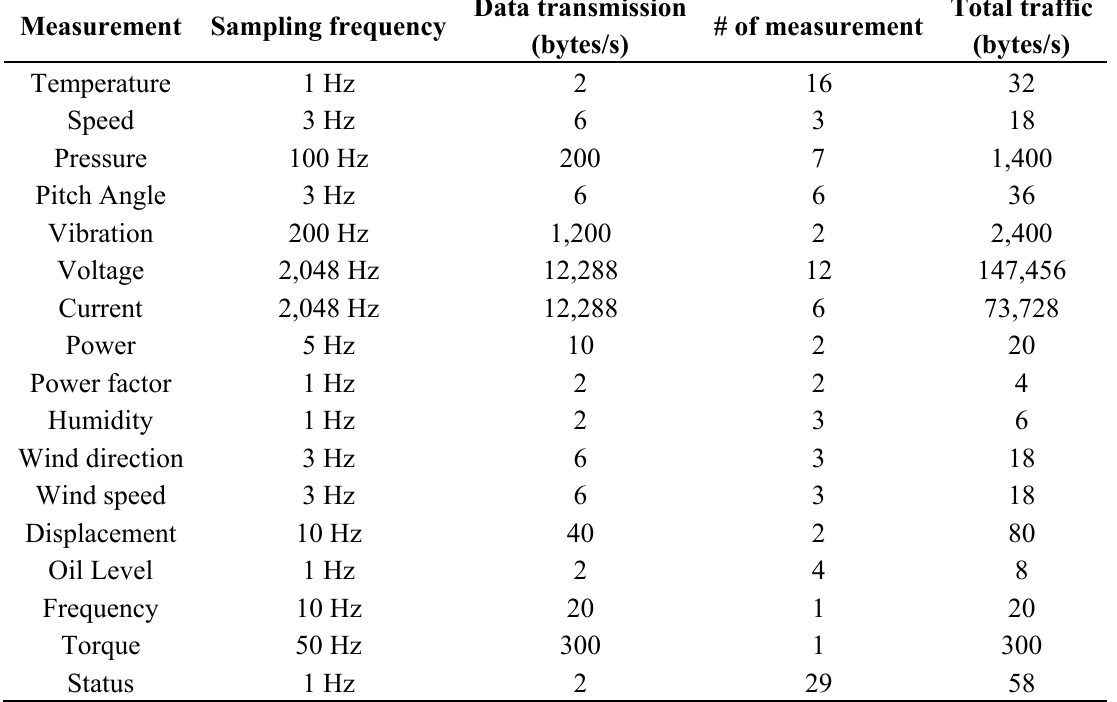
Table 4. Measuring requirements for sensor data (wind